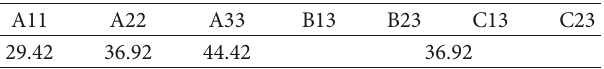
Figure 3: Schematic of test methods of (a) bending force, (b) spring-back force, and (c) stent graft fixation on COLUMN. Table 3: Bending arm lengths of stent grafts